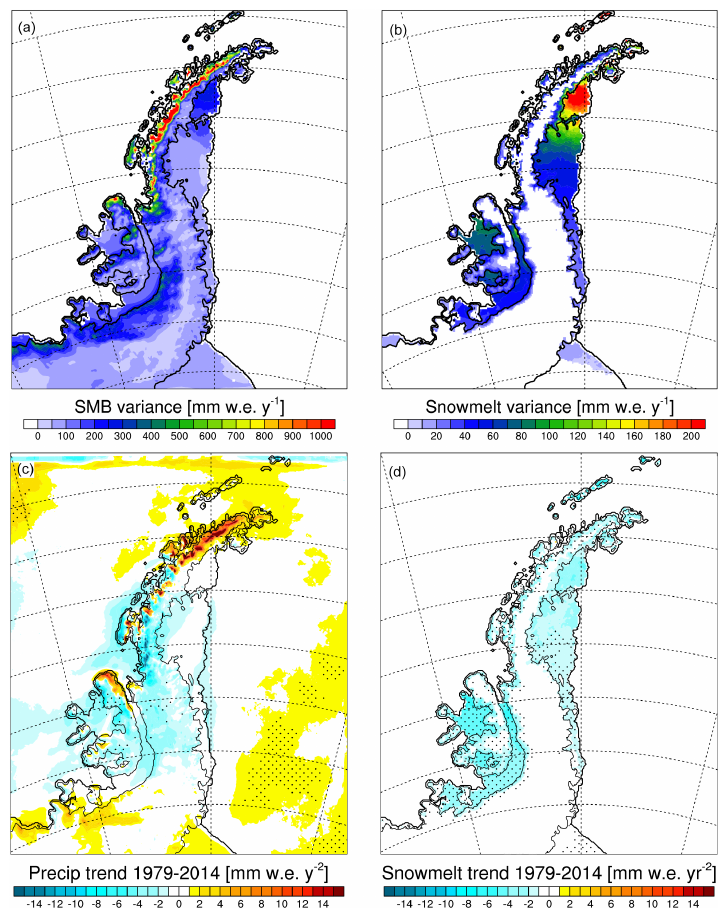
Figure 8. Interannual variability (1 standard deviation, detrended) of SMB components for 1979–2014: SMB (a) , and snowmelt (b) , in mmweyr − 1 . 1979–2014 trends of precipitation (c) and snowmelt (d) in mmweyr − 2 . Stippled pattern represents trends that are significant >